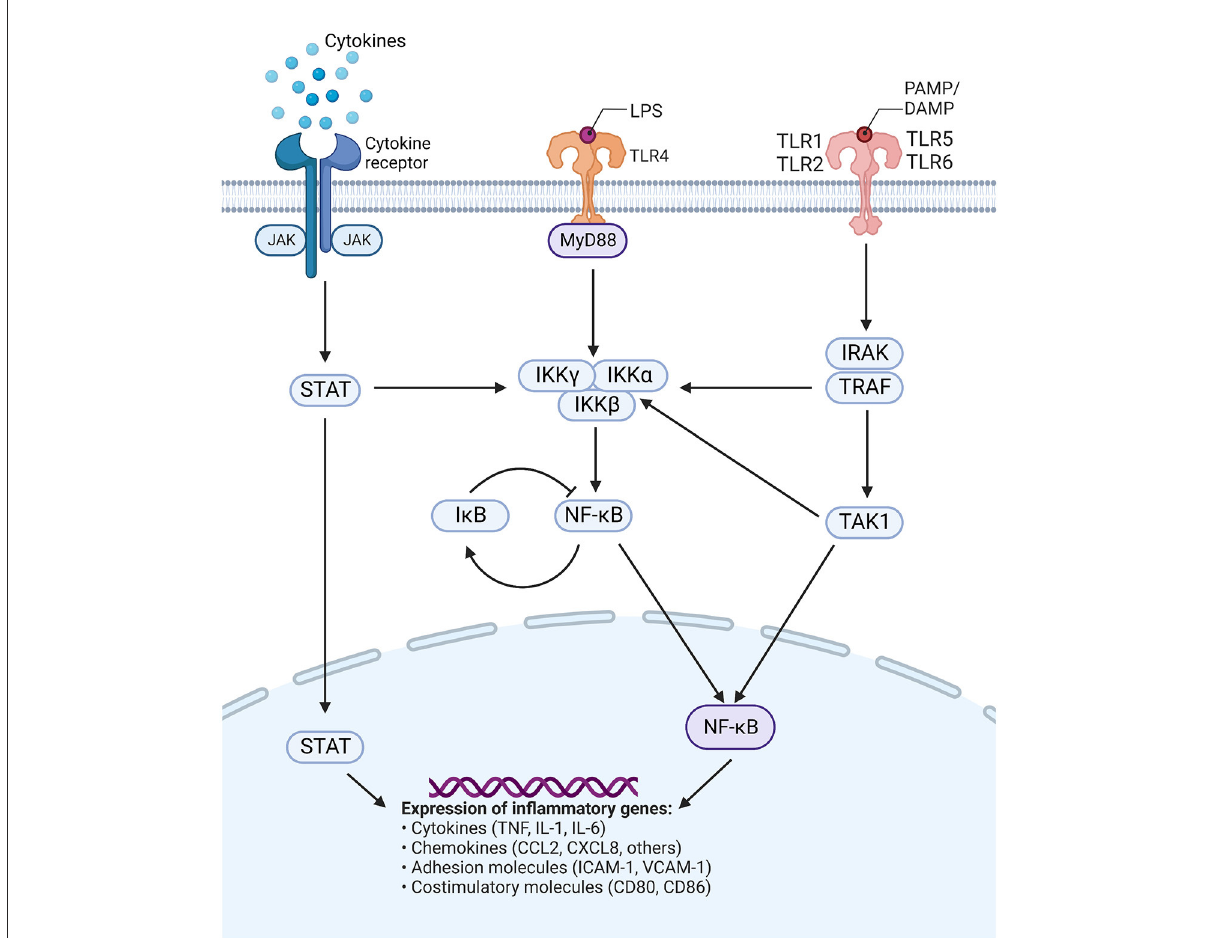
FIGURE1 Common signaling pathways. TLRs are activated by various stimuli, commonly recognizing viral and bacterial products, or host-derived endogenous compounds (i.e., DAMPs or PAMPs, respectively). Triggering of TLRs can activate multiple pathways which produce complexes that activate the IKK structure (comprising catalytic IKK α and IKK β , and regulatory IKK γ subunits). NF- κ B is produced and either translocates to the nucleus or is negatively regulated by phosphorylation of I κ B. In the nucleus, NF- κ B influences the expression of many inflammatory genes, in turn affecting production of cytokines, chemokines, adhesion molecules, and costimulatory molecules. Activation of the JAK/STAT pathway via cytokine receptors also contributes to NF- κ B signaling and alterations in the expression of inflammatory genes. JAK, Janus kinase; STAT, signal transducer and activator of transcription; TLR, toll-like receptor; DAMP, damage-associated molecular patterns; PAMP, pathogen-associated molecular pattern; MyD88, myeloid differentiation primary response 88; IKK, inhibitor of κ B kinase; IRAK, interleukin receptor-associated kinase; TRAF, tumor necrosis factor receptor-associated factor; I κ B, inhibitor of nuclear factor κ B; NF- κ B, nuclear factor κ B; TNF, tumor necrosis factor; IL, interleukin; CCL, CC motif chemokine ligand;; CXCL, CXC motif chemokine ligand; ICAM, intercellular adhesion molecule; VCAM, vascular cell adhesion molecule; CD, cluster of differentiation. Figure adapted from “TLR Signaling Pathway”, by BioRender.com (2015). Retrieved from: https://app.biorender.com/biorender-templates.